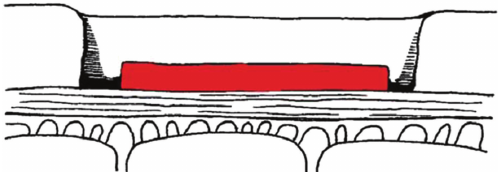
Figure 4: Schematic drawing of the construction of a bony island (in red). The cortical bone is thinned in the middle of the CI-shaped well, and the dura is completely uncovered at the borders of this well, creating an “island” of cortical bone protecting the